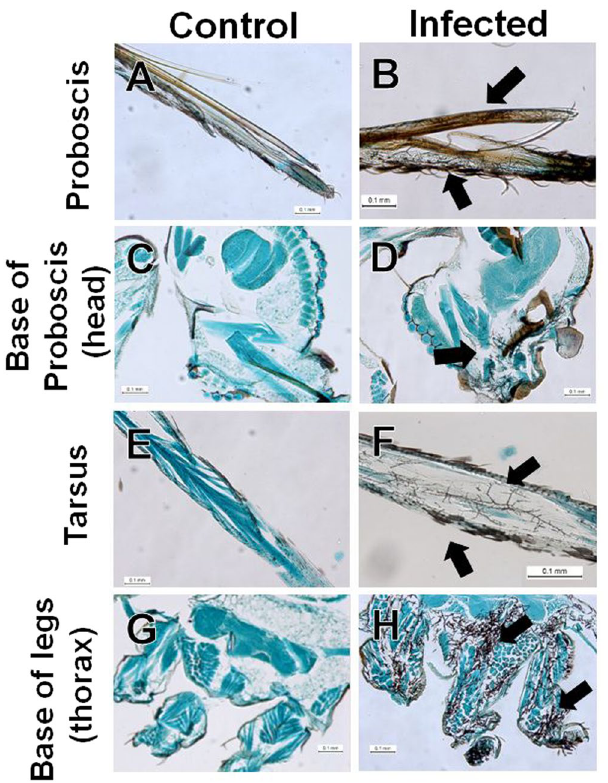
Figure 4. Images showing fungal invasion of the head and thorax from the proboscis and tarsus. ( A , C , E and G ) show uninfected organs. ( B , D , F and H ) depict the extension of fungal propagules into organs. ( A and B ) Proboscis; ( C and D ) base of the proboscis (head part); ( E and F ) tarsus; and ( G and H ) base of the legs (thorax).